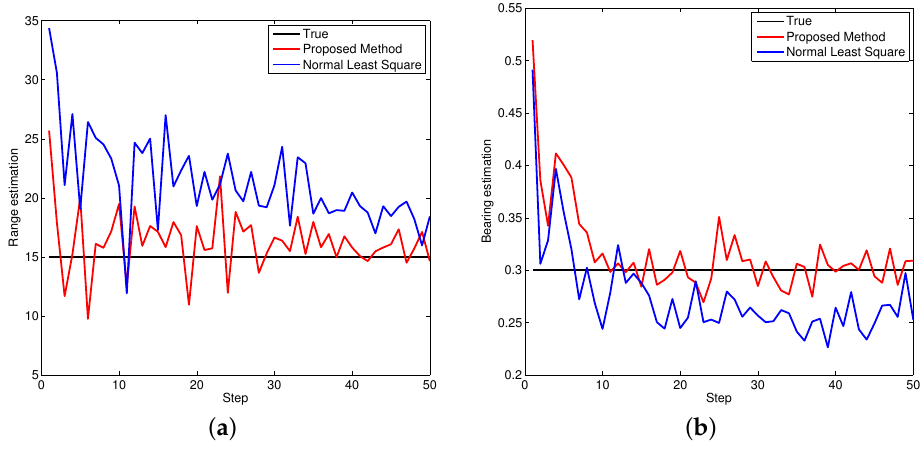
Figure 7. Bias estimations for object three. ( a ) Bias estimation in range; ( b ) Bias estimation in